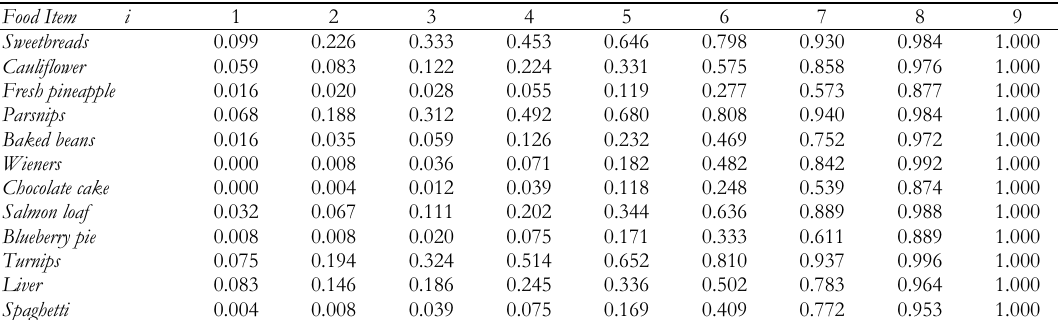
(i), given by Jones k